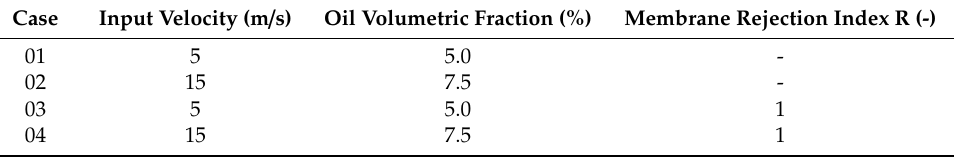
Table 3. Operational parameters used in the simulations.